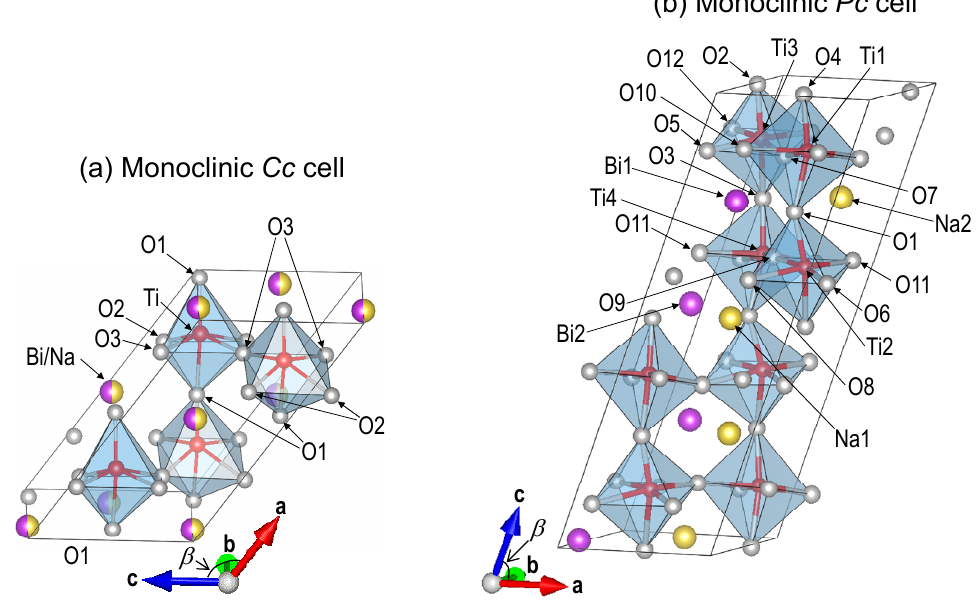
Figure 1. Crystal structures of BNT in the monoclinic space group ( a ) Cc and ( b ) Pc cells. The Cc structure in ( a ) is drawn from the structural parameters reported by Aksel et al. [19]. In this Cc cell, Bi and Na are randomly distributed on the A site. The monoclinic supercell in space group Pc [BiNaTi O , Z = 4, see ( b )], in which the structural 2 6 feature in the Cc cell can be taken into account. In the Pc cell, the nearest-neighbor